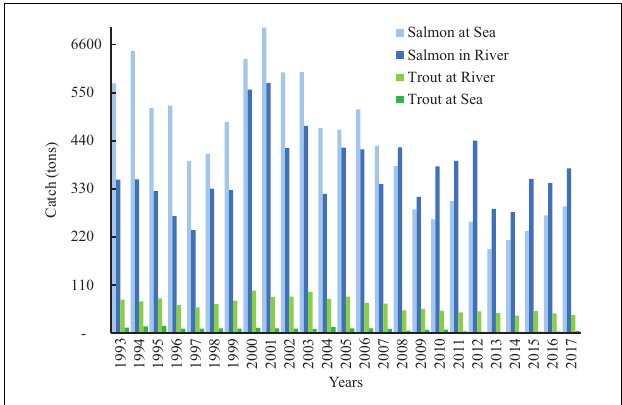
FIGURE 2 | Salmon and sea trout catches in both sea and rivers. Source: Statistics Norway